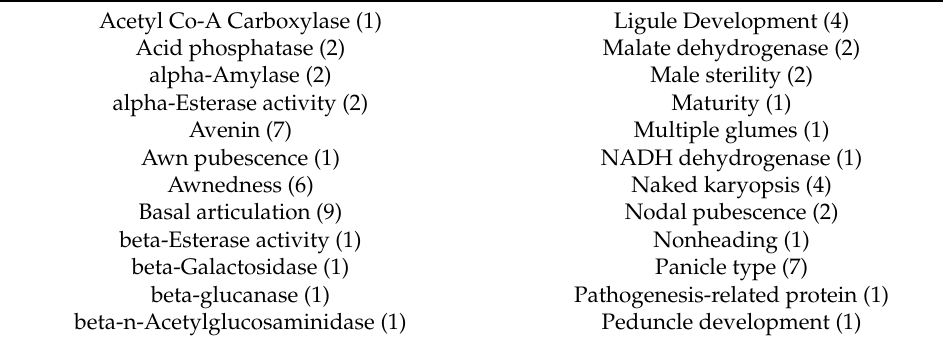
Table 1. Gene Classes with number of Avena genes in parenthesis in